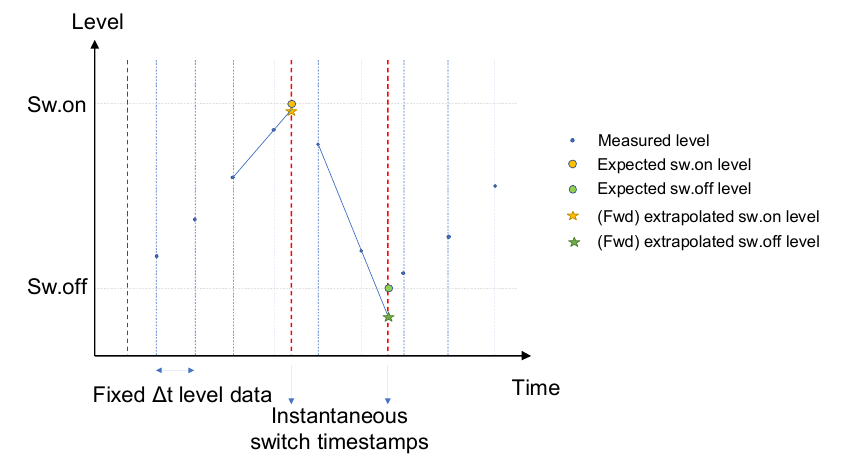
Figure A2. Estimation of switch levels by forward extrapolation.